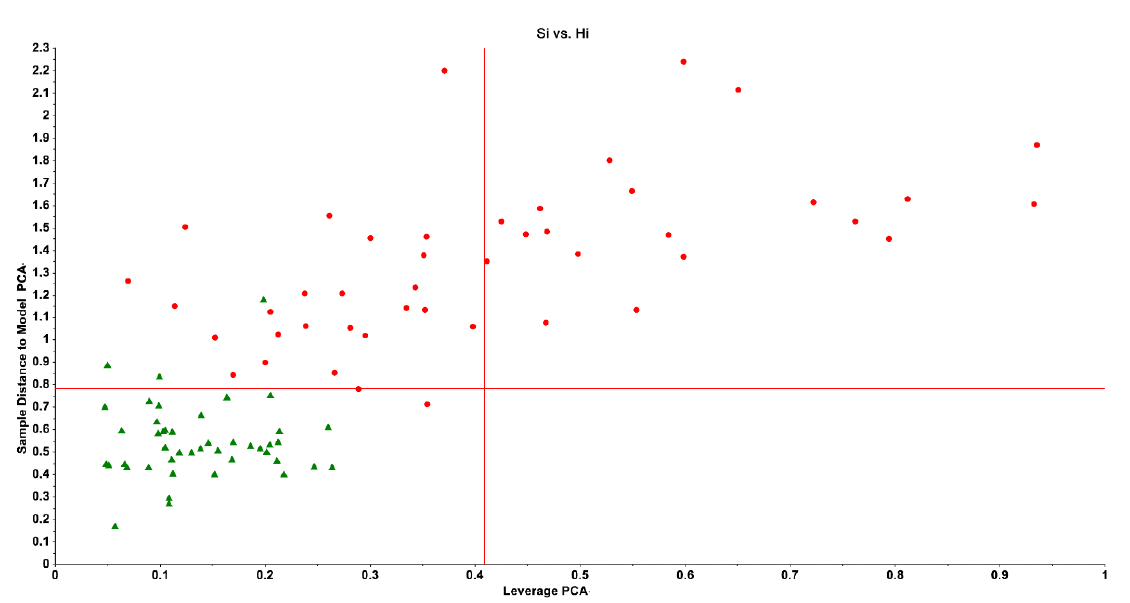
Figure 2. A Si/Hi plot (distance between the cases and the class model/distance between the cases and the class center or leverage) obtained by soft independent modeling of class analogy (SIMCA). Green triangles: normal volunteers; red bullets: patients with major depression.